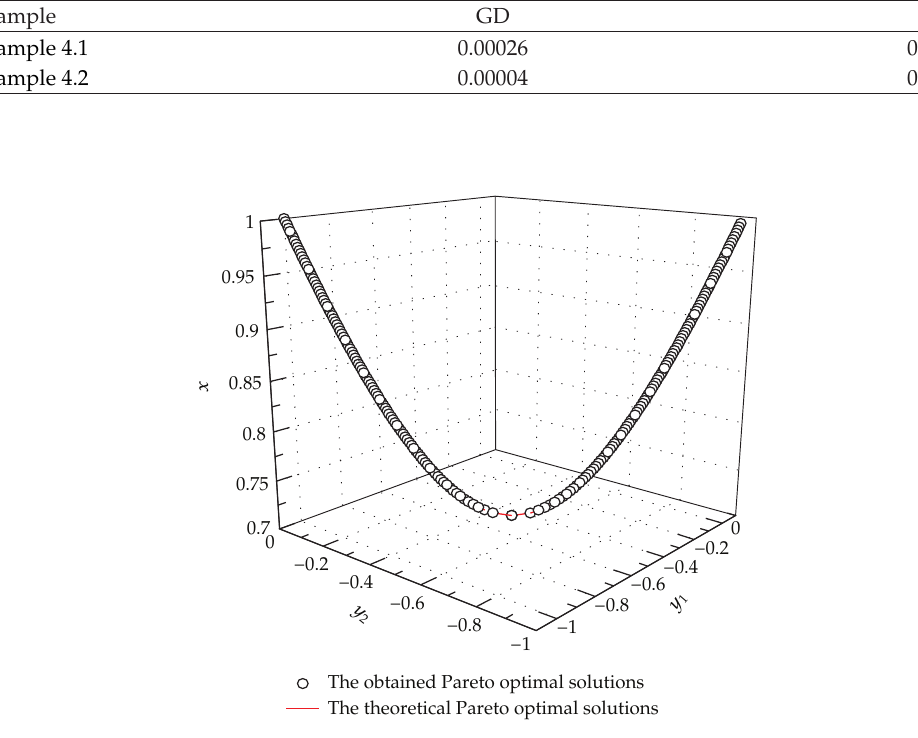
Figure 2: The obtained solutions of Example